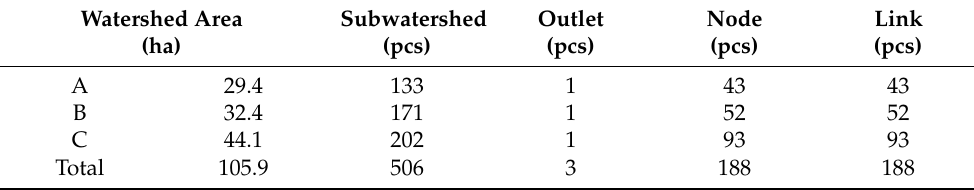
Table 2. Pipe network.